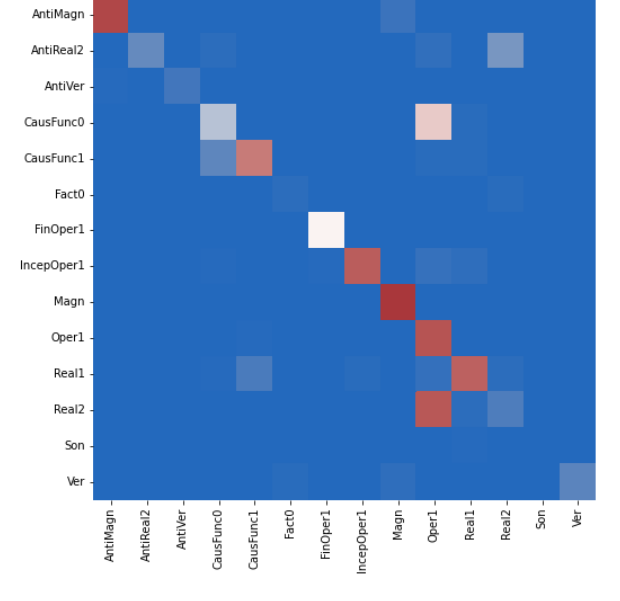
Figure 5. Confusion matrix for the classification of all LFs by our relation model on the French test